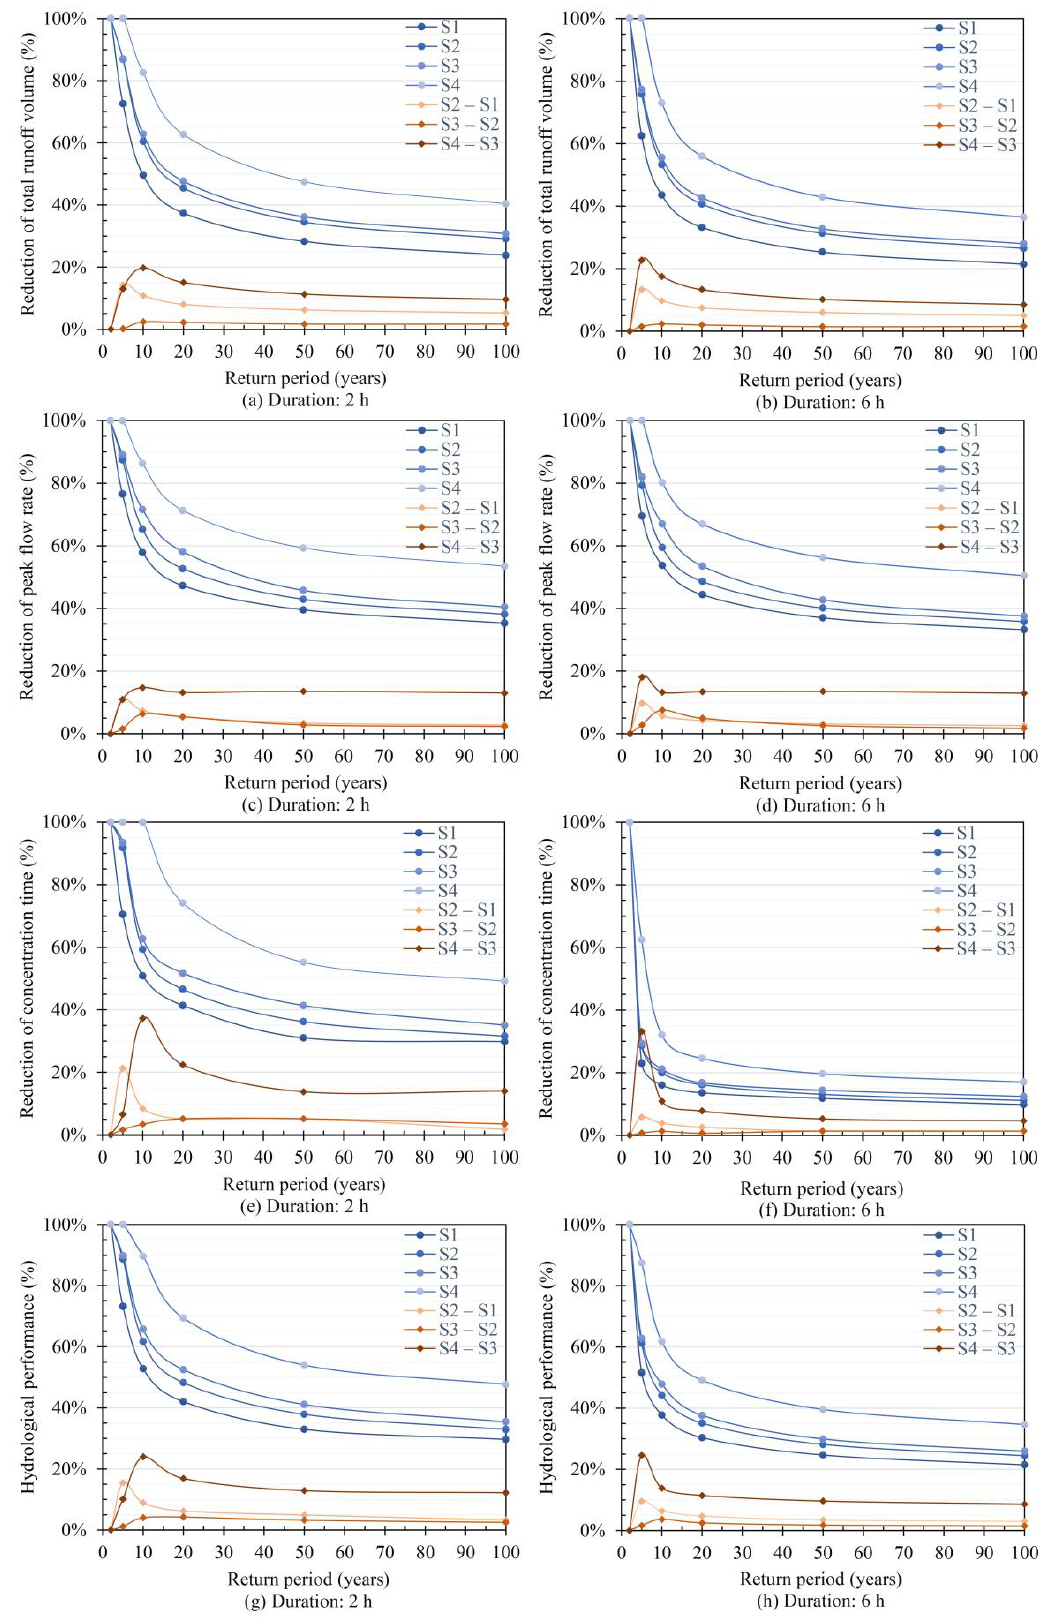
Figure 10. Analysis of 𝑅 𝑉𝑜𝑙 ( a , b ), 𝑅 𝑄 ( c , d ), 𝑅 𝑇𝐶 ( e , f ), and hydrological performance ( g , h ) for S1, S2, S3, and S4 as responses to various return periods and rainfall durations.